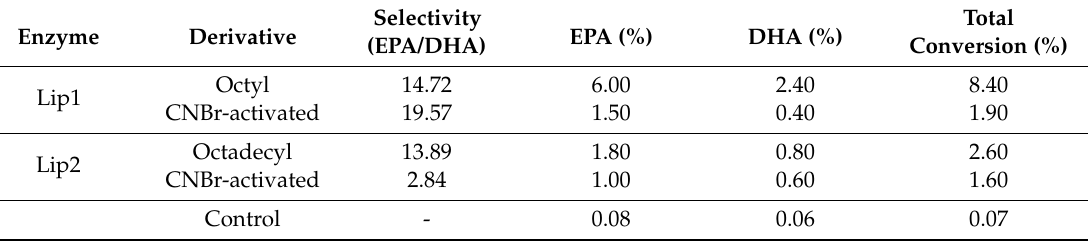
Table 7. Sardine oil hydrolysis catalyzed by F. verticillioides lipase immobilized on hydrophobic